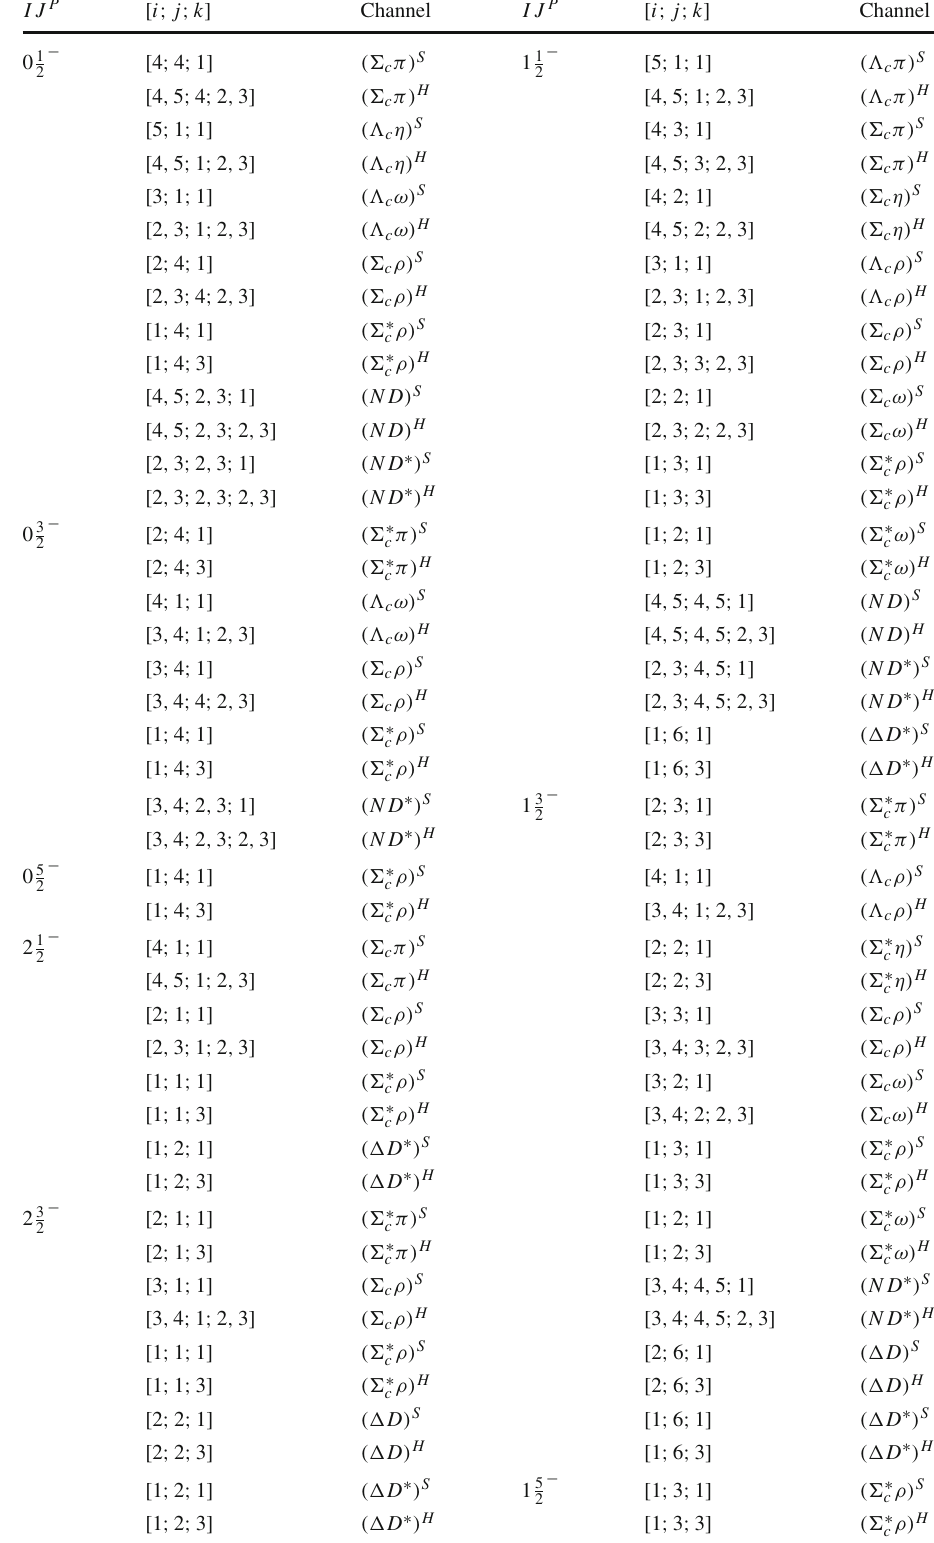
Table 3 Physical channels for qqq ¯ qc pentaquark